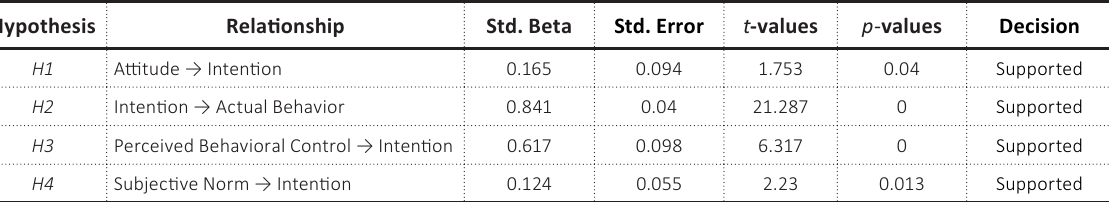
Table 6. Hypothesis